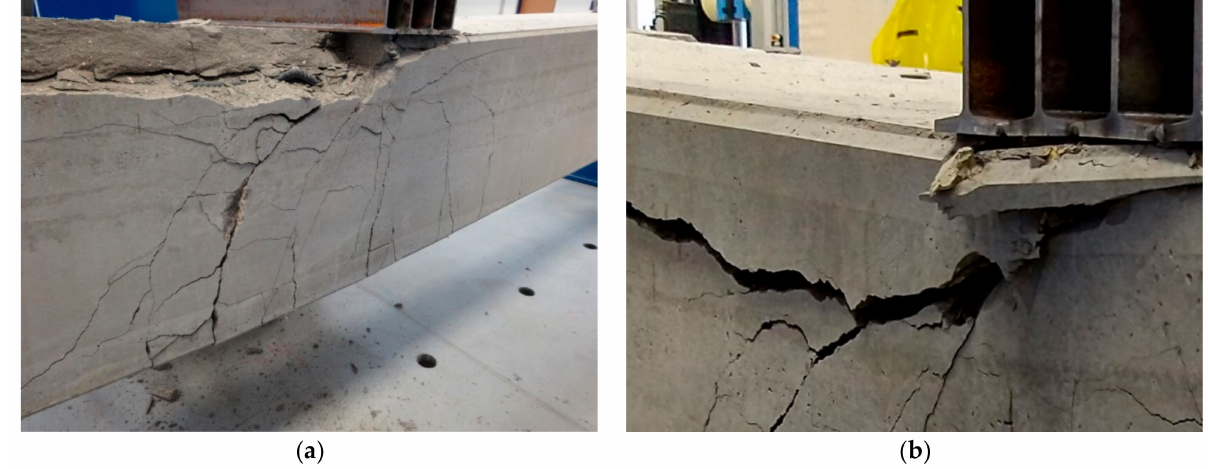
Figure 11. Failure of HPC beam: crack pattern ( a ), and rupture of the compressed part of the cross-section ( b ).